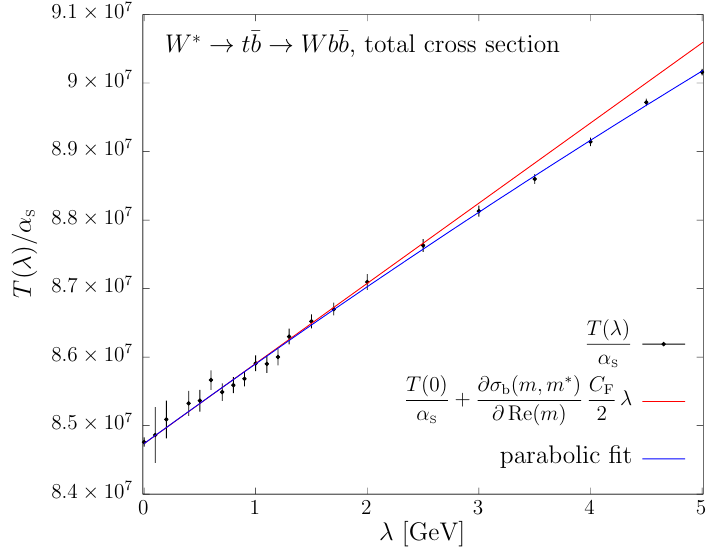
Figure 2 . Small (cid:21) behaviour of T ( (cid:21) ) for the total cross section as function of the gluon mass (cid:21) . In black the data points computed with our numerical calculations, in red the linear (cid:21) dependence and in blue the parabolic (cid:12)t of the points. The (cid:21) = 0 point has been obtained by performing the standard NLO computation in dimensional